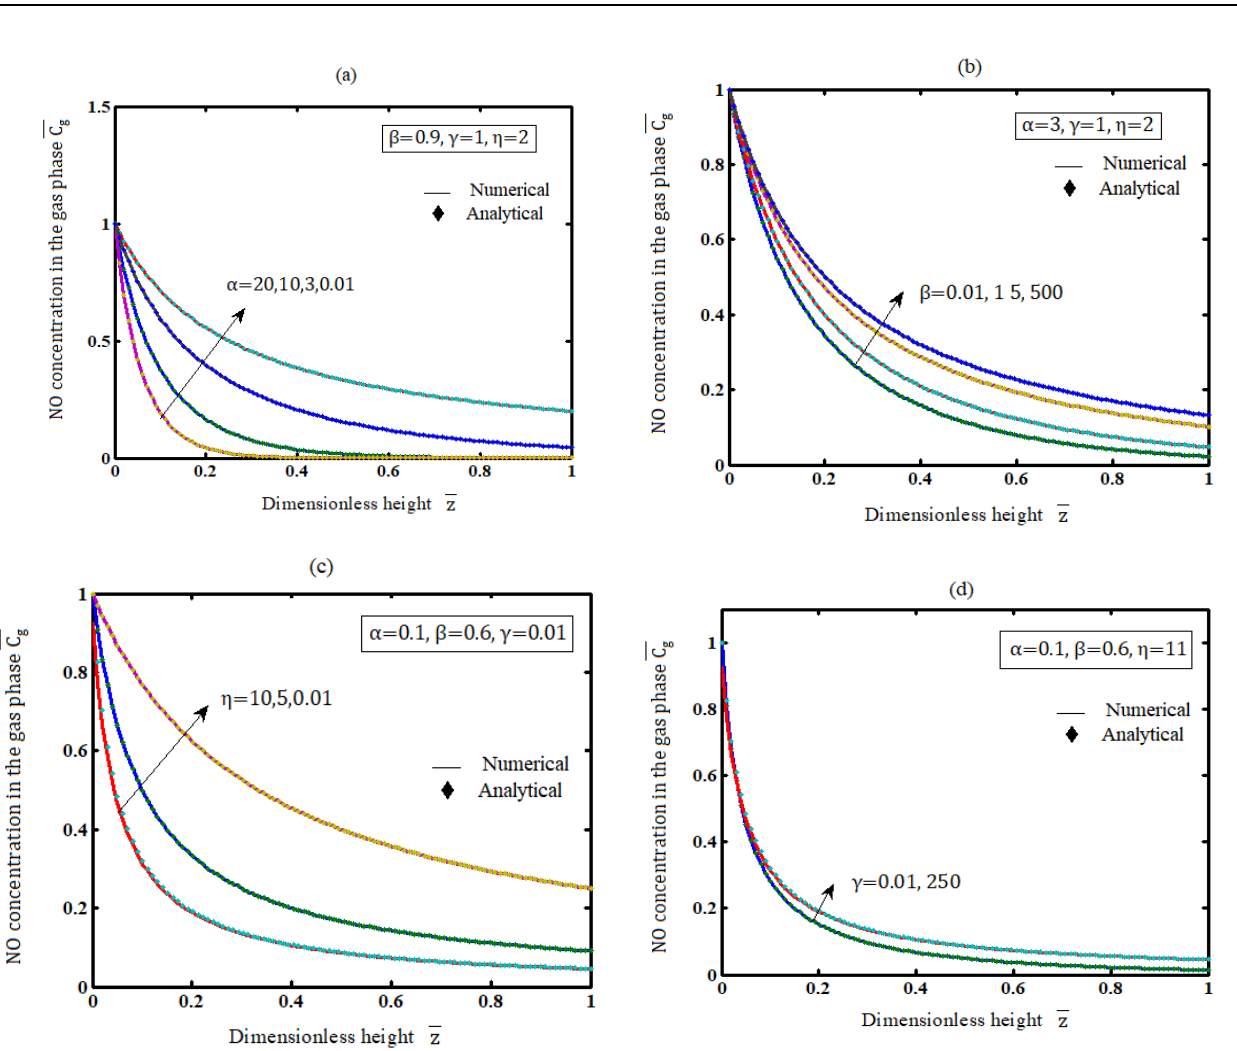
Figure 2. Dimensionless NO concentration in the gas phase using Equation (20) for the experimental values (Table A1)of the parameters ( a ) α . ( b ) β . ( c ) η . ( d ) γ .